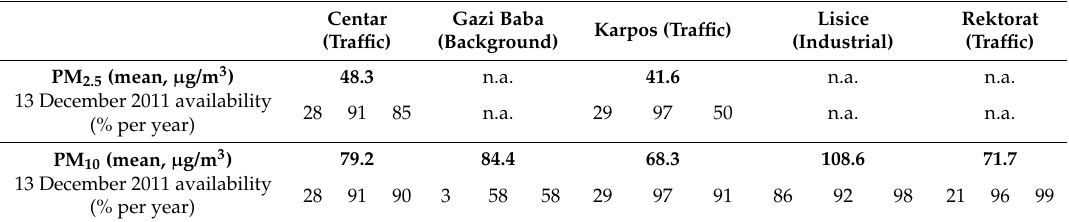
Table 1. Data availability and mean values by pollutant and monitoring station in Skopje for three consecutive years.